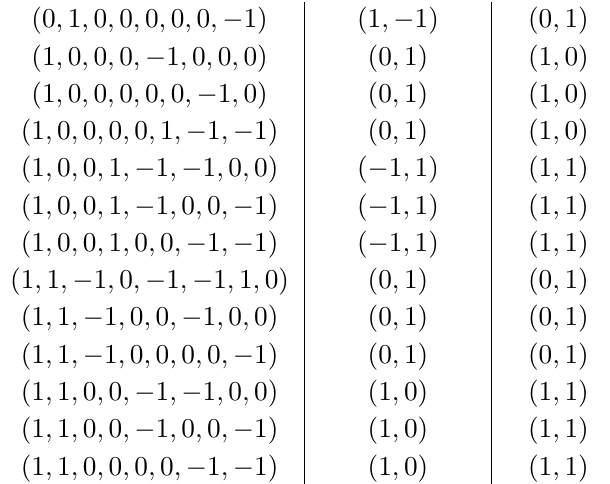
∗ . The middle column is the s → IV